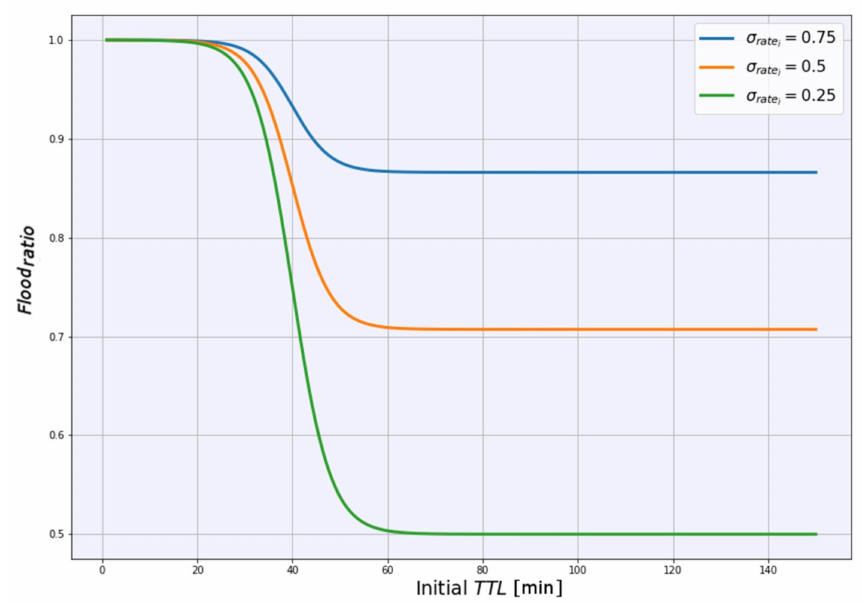
Figure 5. Graph of Flood ratio , from Equation (7), as a function of the initial Time-To-Live (TTL) and distinct penetration